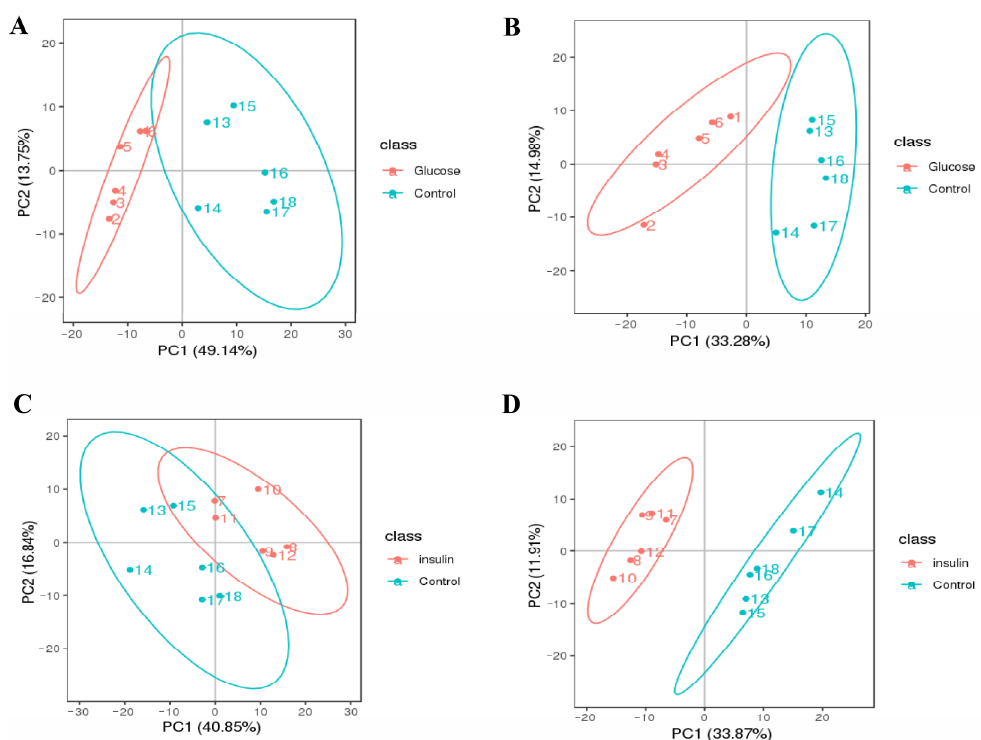
Figure 4. Principal component analysis of QC samples of serum metabolites from acute hyperglycemic/hypoglycemic chickens and control birds. ( A ) Acute hyperglycemic chickens and control birds PCA plot positive-ion pattern. ( B ) Acute hyperglycemic chickens and control birds PCA plot negative ion pattern. ( C ) Acute hypoglycemic chickens and control birds PCA plot positive ion pattern. ( D ) Acute hypoglycemic chickens and control birds PCA plot negative ion pattern. Abscissa PC1 and ordinate PC2 in the figure indicate the scores of principal components ranked first and second, respectively, and scatter in different colors indicates the samples of different experimental groups, with ellipses of 95% confidence intervals.